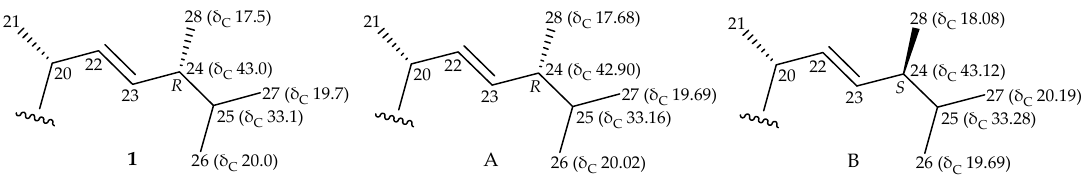
Figure 3. The 13 C-NMR chemical shifts of the side-chain of secosterol 1 , (22 E ,24 R )-24-methyl-cholesta- 5,22-dien-3 β -ol (A) and (22 E ,24 S )-24-methylcholesta-5,22-dien-3 β -ol (B) [8].